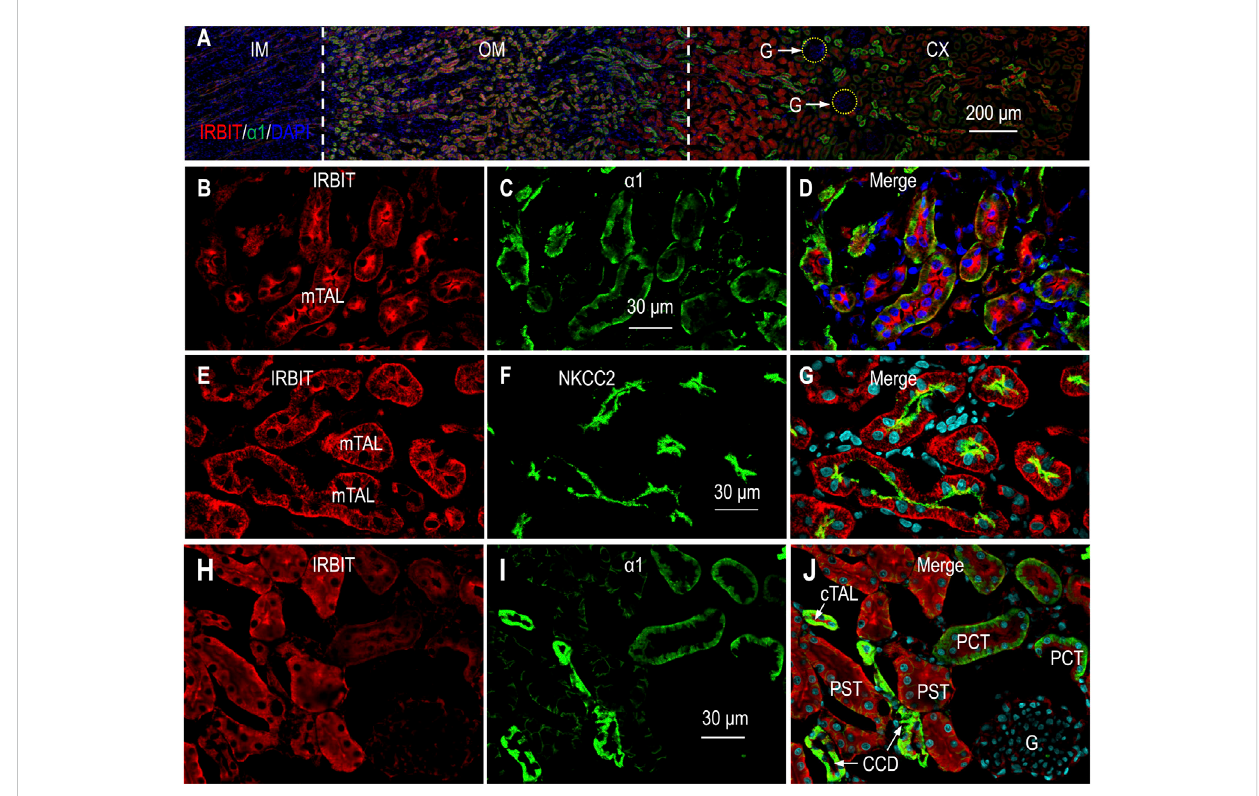
FIGURE 2 Indirect immuno fl uorescence of IRBIT in rat kidney. (A) Merged overview of double staining of IRBIT (red) and α 1 (green) in a rat kidney section. The original unmerged images of IRBIT and α 1 were shown in Supplementary Figure S1. (B – D) High magni fi cation view showing that IRBIT is abundantly expressed in mTAL. (E – G) Localization of IRBIT and NKCC2 in mTAL. (H – J) Localization of IRBIT (red) and α 1 (green) in cortex. G, glomerulus; mTAL, medullary thick ascending limb; CX, cortex; OM, outer medulla; IM, inner medulla. Blue indicates the nuclei counter-stained with